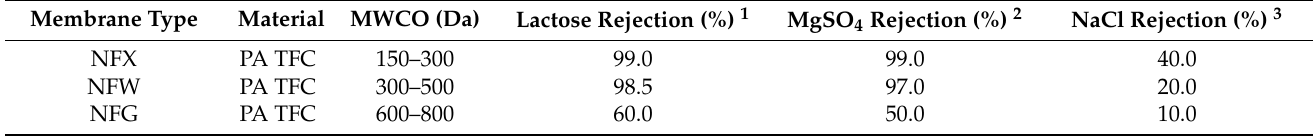
Figure 3. Scheme of the NF experimental set-up. Table 4. Characteristics of the selected NF membranes.